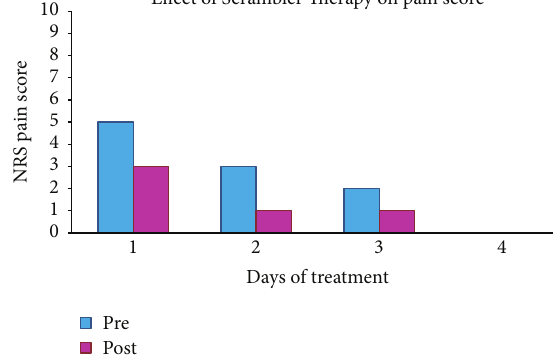
Figure 5: Effect of Scrambler Therapy on pain score during days of